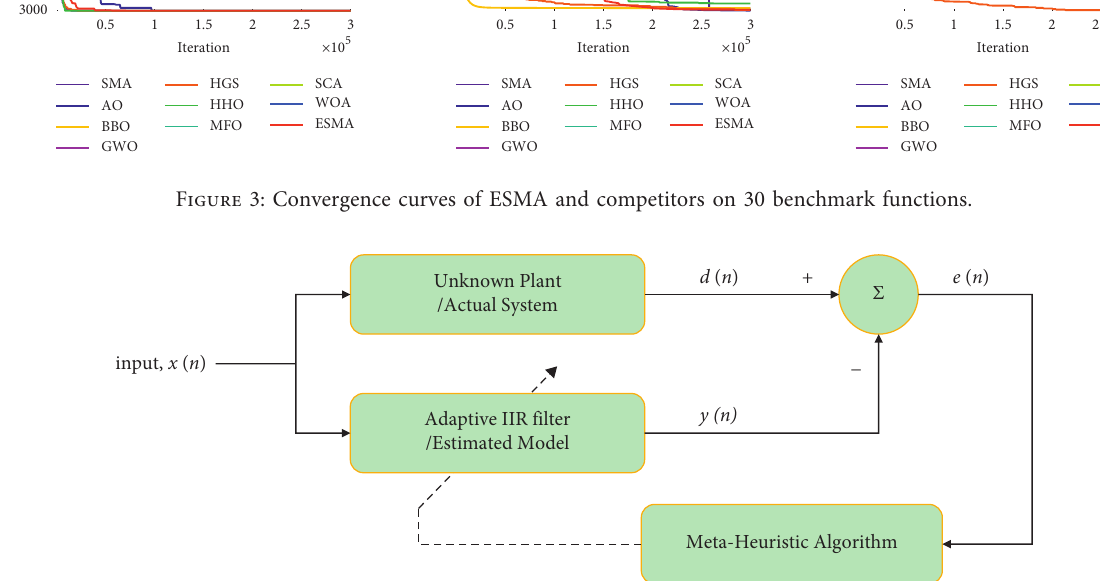
Figure 4: Block diagram for digital IIR model identification